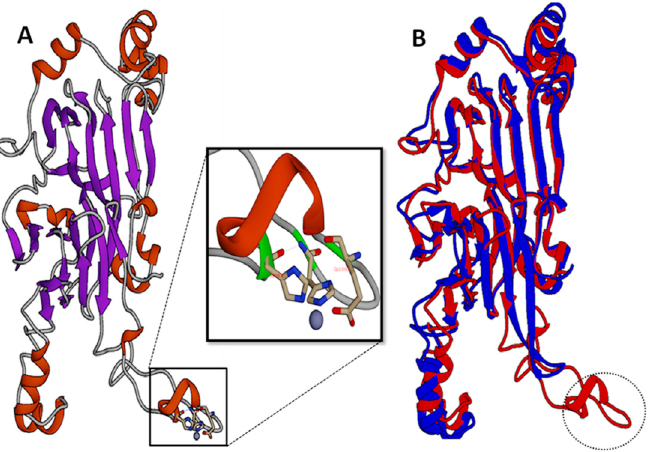
Fig 10. 3D modelled momomeric structure of cupincin. (A) : Illustration to show the computed monomeric structure of cupincin containing typical characteristics of cupin superfamily. Alpha helix portions are coloured in red, pleated beta sheets in blue. The beta-rich cupin fold can be easily distinguished between the alpha- helix segments that contribute to inter-subunit interactions. Fig 10A (Magnified): View of the active site of cupincin the zinc ion (dark grey ball) coordinated by conserved protein residues His 313, HIS 326 and GLU 318. ( B): Superimposition of homology modelled cupincin structure (Red) with its template 3SMH A chain (Blue). (http://www.dsimb.inserm.fr/dsimb_tools/ipba/index.php). Broken circle indicating the presence of active site region only in cupincin but missing in the template.